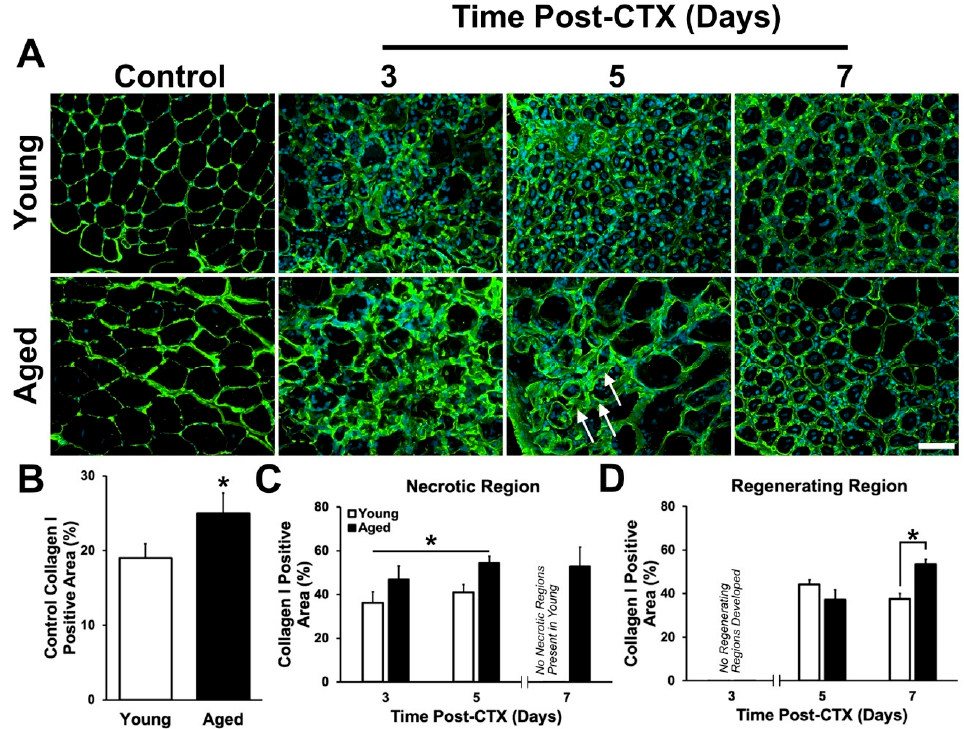
Figure 4. Collagen I expression is greater in the necrotic regions of aged muscle. ( A ) Immunostaining of collagen I (green) and DAPI (blue) at each time point following damage. Arrows denote regions of dense collagen I persistent at 5 days post-CTX in aged muscle. ( B ) Collagen I positive area in the undamaged contralateral leg was observed to be greater in aged muscle compared to young ( t -test: p = 0.006; indicated by *). ( C ) Percent positive area of collagen I was greater in the necrotic region of aged muscle at three and five days following damage. * denotes a significant main effect of age ( p = 0.002). ( D ) A significant interaction between age and recovery time points was observed ( p = 0.034). Simple main effect post-hoc analysis demonstrates a significantly greater accumulation of collagen I in the regenerating region of aged muscle at seven days following damage ( p = 0.024). * indicates significant differences detected by a simple main effects post-hoc analysis ( p = 0.024). n = 4–5 per group. Data presented are means ± standard deviation. Scale bar represents 50 µ